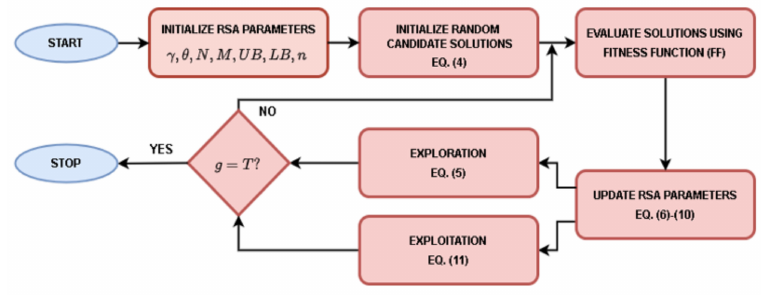
Figure 2. The flow diagram of the